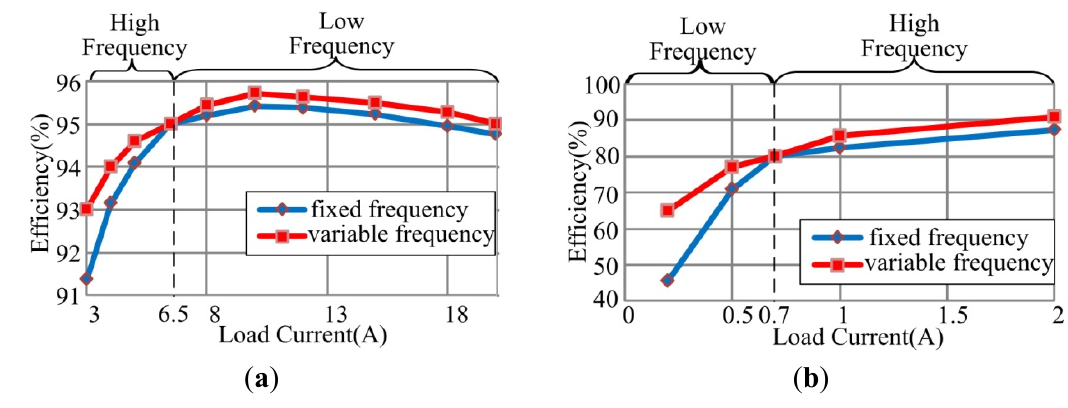
Figure 30. Efficiency comparison between the fixed frequency control and variable frequency control ( a ) at mid and heavy loads; ( b ) at light loads.